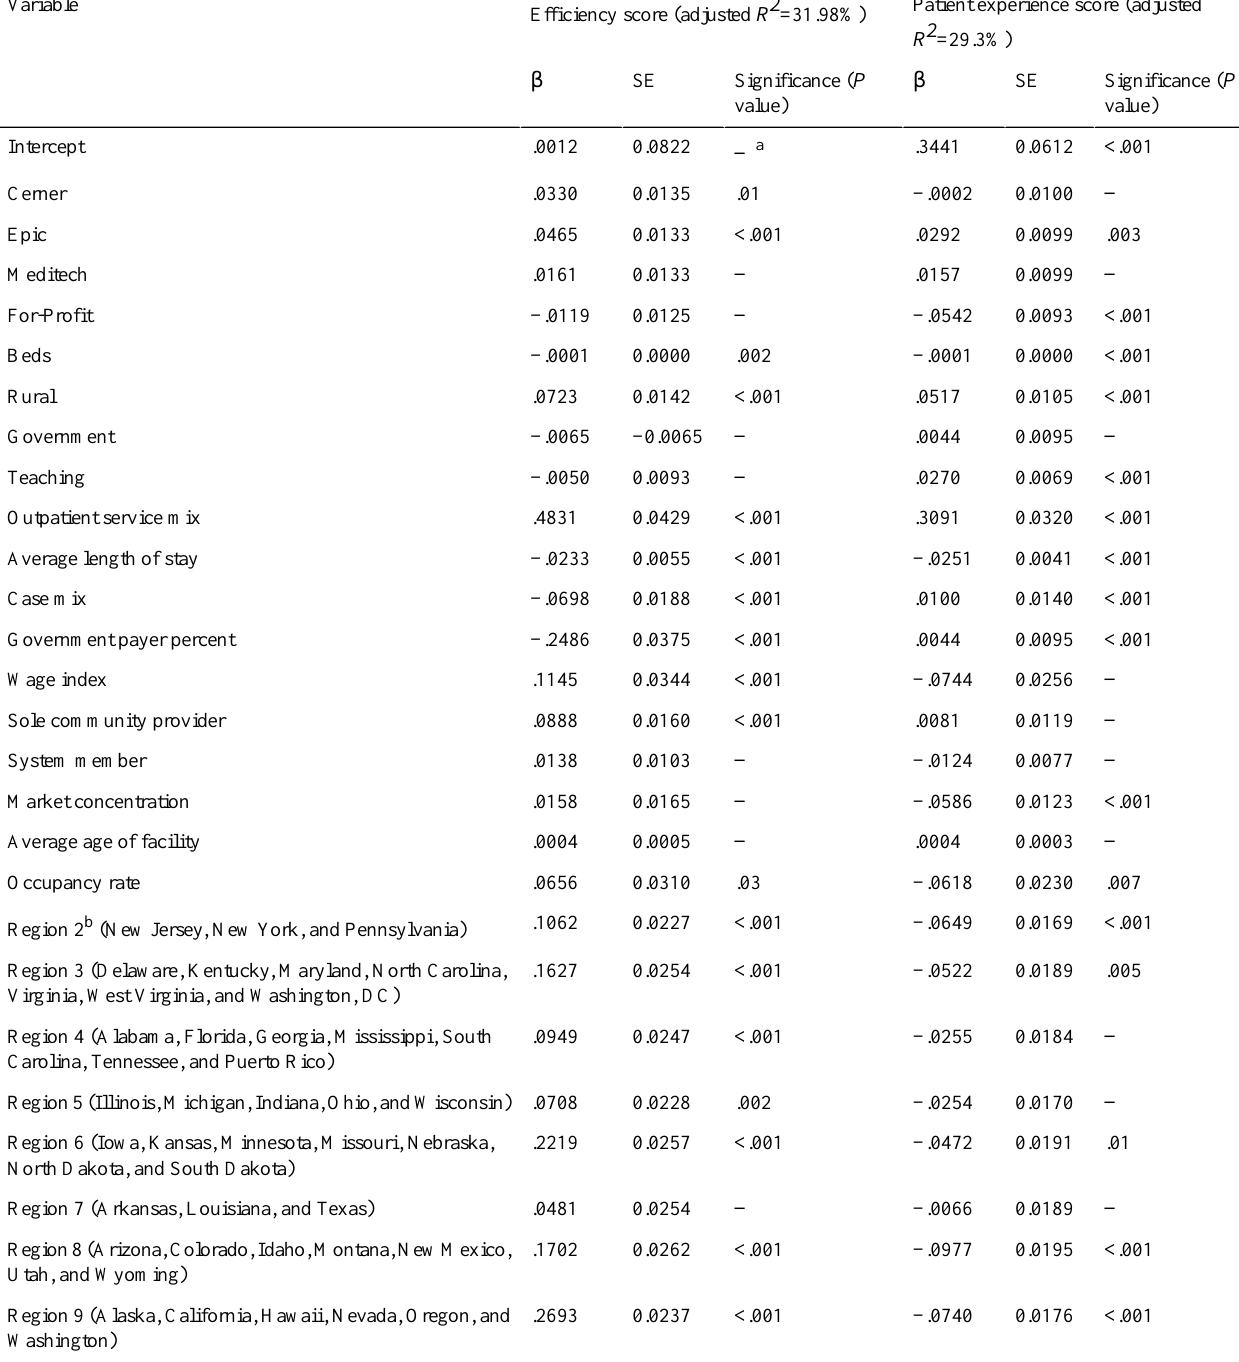
Patient experience score